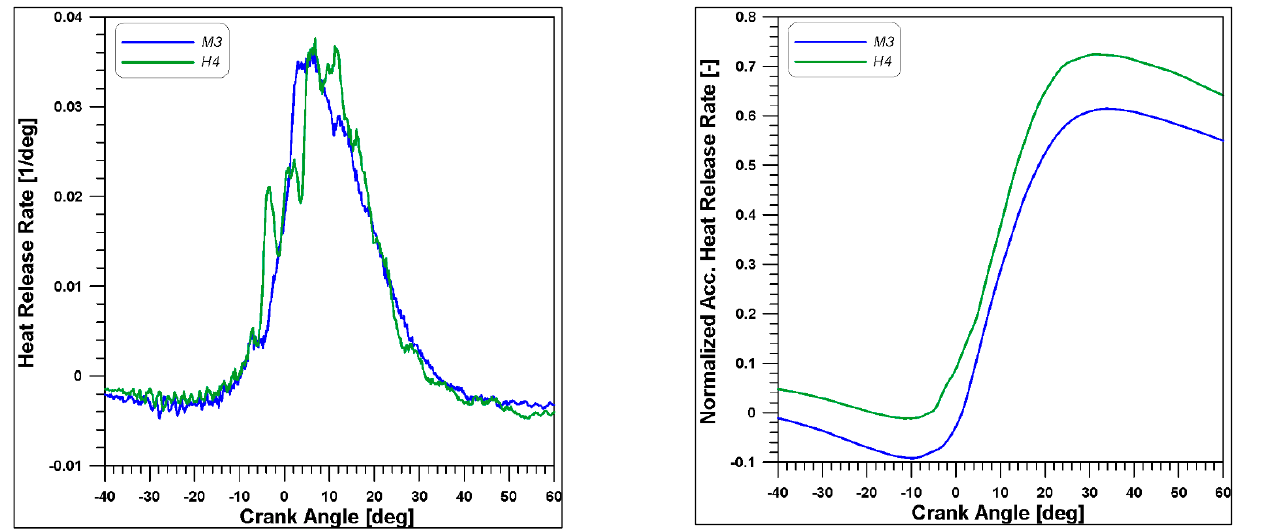
Figure 7. Comparison of normalized heat release rate and accumulated heat release (M3 vs. H4).